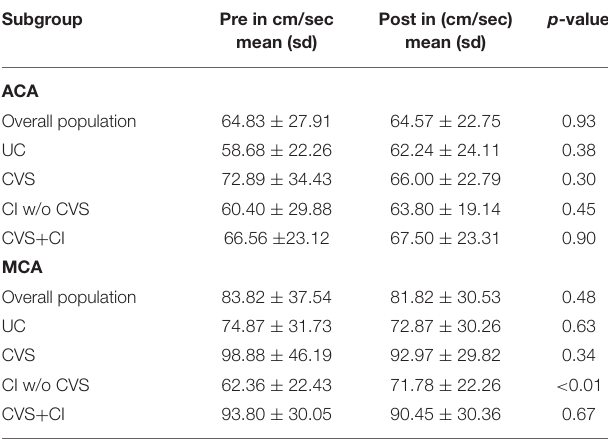
TABLE 2 | Flow velocities values pre and post nimodipine